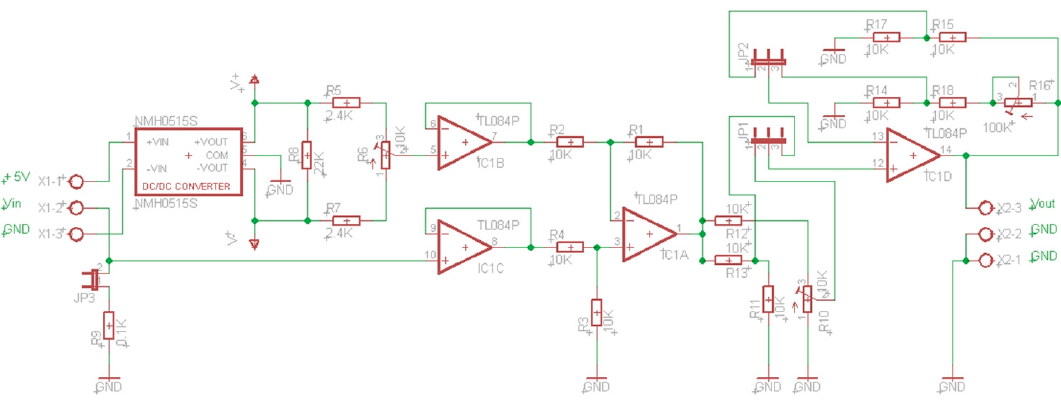
Figure 4. MCLAL circuit from 0/3.3 V to 0/5 V.